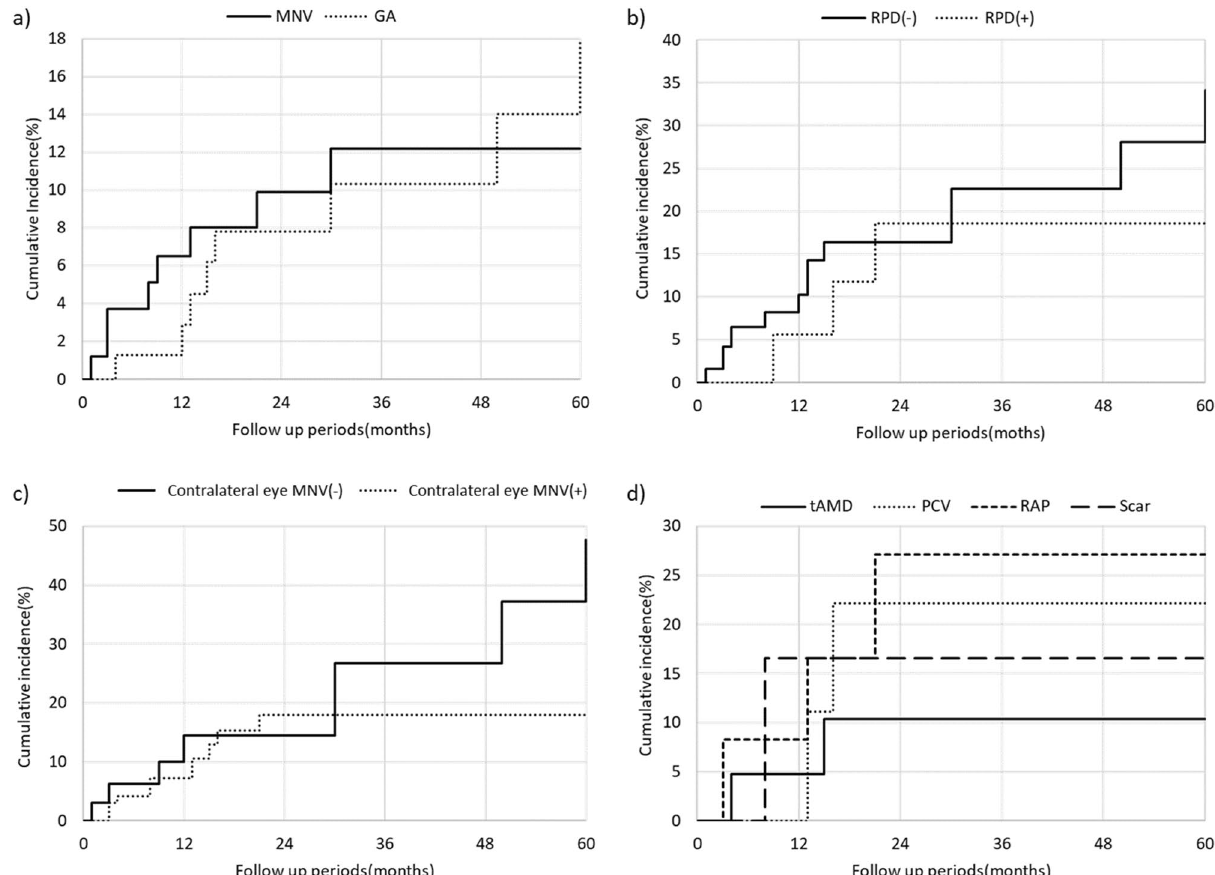
Figure 1. ( a ) Cumulative incidence of geographic atrophy (GA) and macular neovascularization (MNV) at the 5-year follow-up. The cumulative incidence of GA was 2.9%, 7.8%, 10.3%, 10.3%, and 17.9% in the 1-year, 2-year, 3-year, 4-year, and 5-year follow-up respectively. The cumulative incidence of MNV was 6.5%, 9.9%, 12.2%, 12.2%, and 12.2% in the 1-year, 2-year, 3-year, 4-year, and 5-year follow-up respectively. ( b ) Cumulative incidence of advanced age-related macular degeneration (AMD) depends on the presence or absence of reticular pseudodrusen (RPD) during a 5-year follow-up. The cumulative incidence of advanced AMD in RPD (+) patients was 5.6%, 18.6%, 18.6%, 18.6%, and 18.6% at the 1-year, 2-year, 3-year, 4-year, and 5-year follow-up respectively. The cumulative incidence of advanced AMD in RPD (−) was 10.2%, 16.4%, 22.6%, 22.6%, and 34.1% at the 1-year, 2-year, 3-year, 4-year, and 5-year follow-up respectively. There was no difference in the incidence of advanced AMD between patients with and without RPD. ( p = 0.38, log-rank test). ( c ) Cumulative incidence of advanced AMD was dependent on the presence or absence of MNV in the contralateral eye during a 5-year follow-up. The cumulative incidence of advanced AMD in MNV (+) in the contralateral eyes was 7.2%, 18.0%, 18.0%, 18.0%, and 18.0% at the 1-year, 2-year, 3-year, 4-year, and 5-year follow-up respectively. The cumulative incidence of advanced AMD in MNV (−) in the contralateral eye was 14.5%, 14.5%, 26.7%, 26.7%, and 47.7% at the 1-year, 2-year, 3-year, 4-year, and 5-year follow-up respectively. There was no difference in the incidence of advanced AMD between patients with and without RPD. ( p = 0.17, log-rank test). ( d ) Cumulative incidence of advanced AMD was dependent on the MNV subtypes in the contralateral eye during a 5-year follow-up. The cumulative incidence of advanced AMD in the contralateral eye with retinal angiomatous proliferation, polypoidal choroidal vasculopathy, typical neovascular AMD, and scarring was 27.1%, 22.2%, 10.4%, and 16.6% in the 5-year follow-up, eyes with intermediate AMD and revealed that the presence of drusenoid PED increased the risk for neovascular AMD and the PED width, but not height, which was associated with the development of neovascular AMD 8 . The results are consistent with the results of the present study. Assuming that the drusenoid PED is a hemisphere with a radius “R,” PED width and PED height can represent “2R” and “R,” respectively, although PED height is actually less than “R” because the top of the drusenoid PED is usually flattened. This indicates that the PED width is more closely associated with the PED volume than the PED height, and the results between the studies might be almost the same. However, the PED width was associated with MNV ( p = 0.004), but not with GA ( p = 0.12) in the present study. This might be because the number of participants was small, or the follow-up period was short. The mechanism of the MNV development is not fully understood. In the previous study, it histologically revealed that lipid was packed underneath PED 11 . It has been considered that lipid signaling promotes the